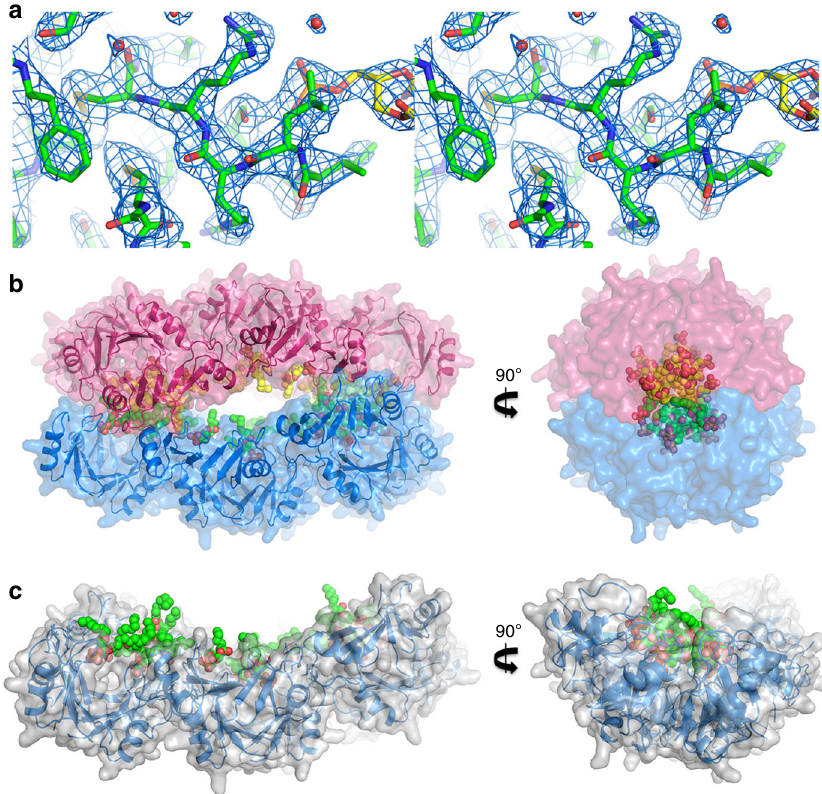
Fig. 3 Crystal structure of the NaD1 – PA complex. a Representative stereo view of the electron density maps for NaD1 – PA structure. The 2Fo – Fc map is shown as a blue mesh contoured at 1.5 σ . Protein carbon atoms are colored green while the PA carbon atoms are colored yellow. Oxygen is colored red, phosphorous orange, nitrogen blue, and sulfur yellow. b The 20-meric NaD1 – PA complex (blue cartoon representation with gray transparent surface rendering) harboring 14 bound PA molecules (shown as spheres with carbon in green, oxygen in red, phosphorus in orange), as viewed from the front (left) and from the side (right). c Two 20-meric complexes in blue and pink cartoon/surface representation, with the PA molecules bound to the top or lower halves, indicated as green/red or yellow/red spheres, respectively. The front view (left) reveals the slight curvature of the complexes, while the side view (right) shows the hydrophobic core created from the acyl chains of bound PA facing inwards towards the center of the